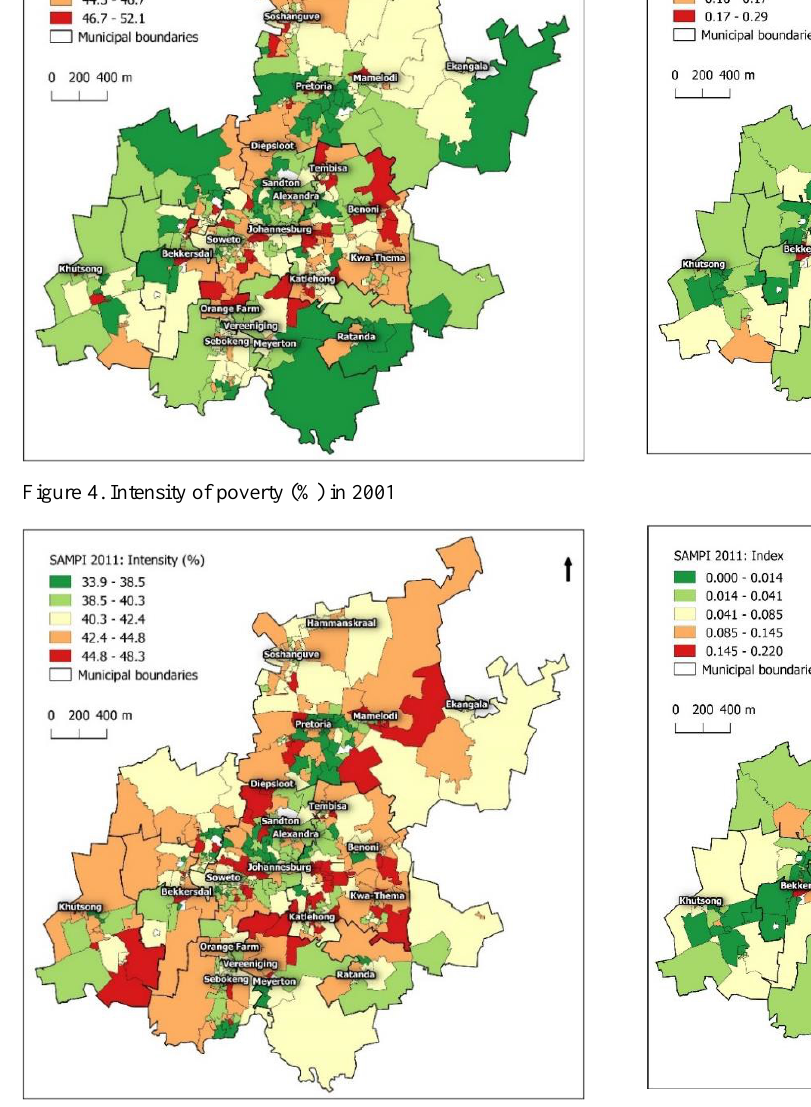
Figure 7. SAMPI in